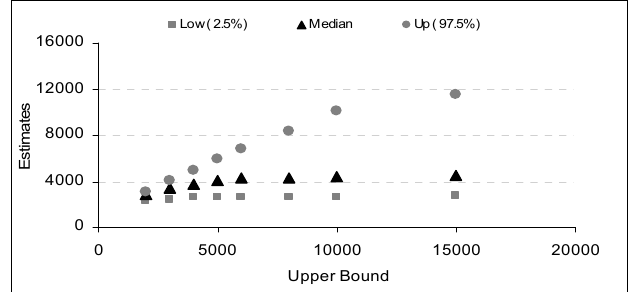
Figure 2 – Dataset B) Independence among sources and a significant effect of continuous covariate: non parametric point estimates of the population size and 95% C.I. according to the upper bound (Bayesian Capture-Recapture model).